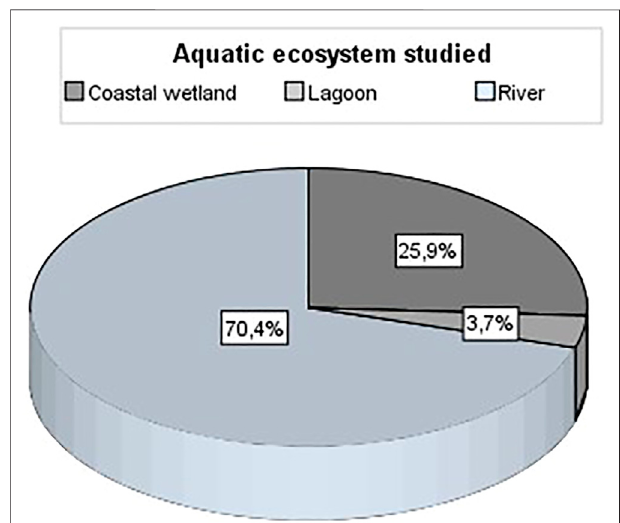
FIGURE 6 | Frequency of aquatic ecosystems where studies on aquatic macroinvertebrates wereconductedinaridandsemi-aridecosystemsofPeru between years 1992 –